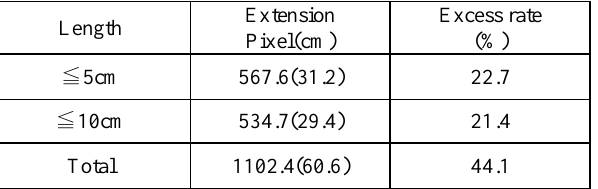
Table 4. List of over-detected cracks